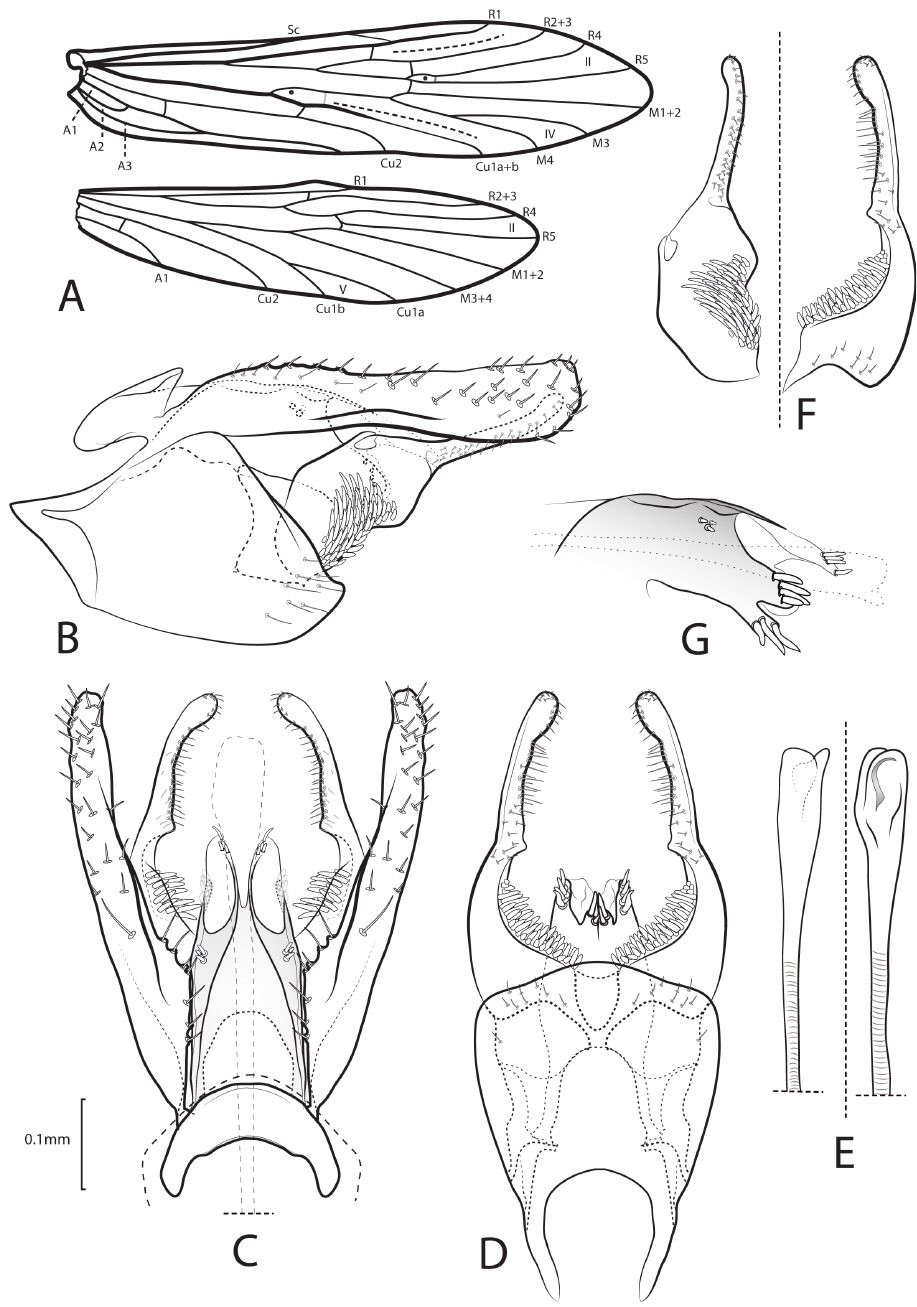
Figure 1. Xiphocentron ( Glyphocentron ) flinti sp. nov., holotype, adult, ♂ A forewing and hindwing. Male genitalia B left lateral C dorsal D ventral E phallus, apex in lateral and dorsal view F detail of right inferior appendage mesal surface, lateral and ventral view G detail of segment X left